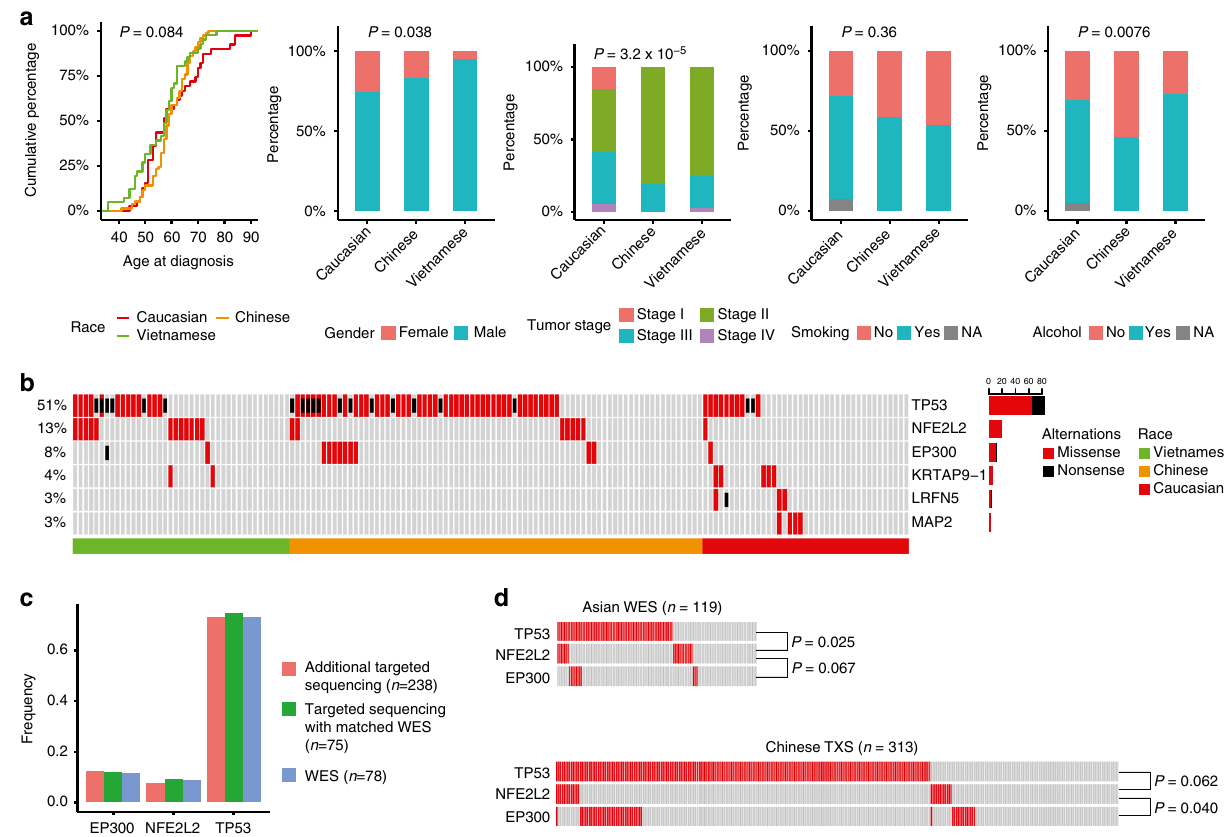
Fig. 4 Race-biased genes identi fi ed by the propensity score algorithm. a Distribution of fi ve biological factors (age at diagnosis, gender, tumor stage, smoking history, and alcohol consumption history) in three patient groups, justifying a need to balance these confounders. Analysis of variance test was used to calculate the P -value for age at diagnosis, and chi-squared test was used for the other factors. b Mutational landscape of six race-biased genes. Genes were ordered by mutational frequencies and samples were grouped by race groups. c Mutational frequencies of EP300 , NFE2L2 , and TP53 in Chinese patients with WES, with targeted sequencing with matched WES and with additional targeted sequencing data. d Mutual exclusivity of TP53 , NFE2L2 , and EP300 . On the top are based on the WES data of combined Chinese and Vietnamese patients, and on the bottom are the targeted sequencing data for 313 Chinese patients. P -values were calculated by CoMEt